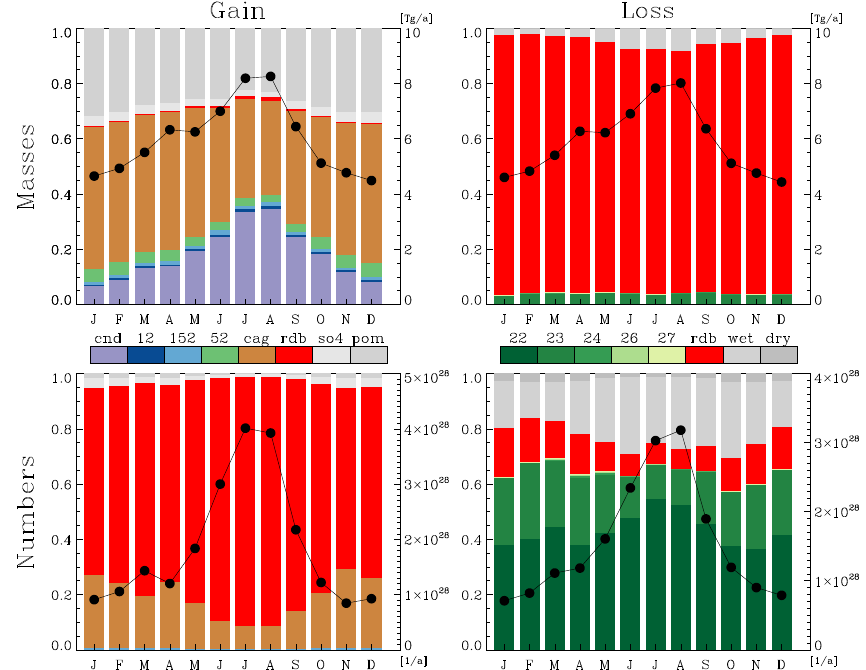
Fig. 12. Seasonal cycle of regional tendencies of the hydrophilic